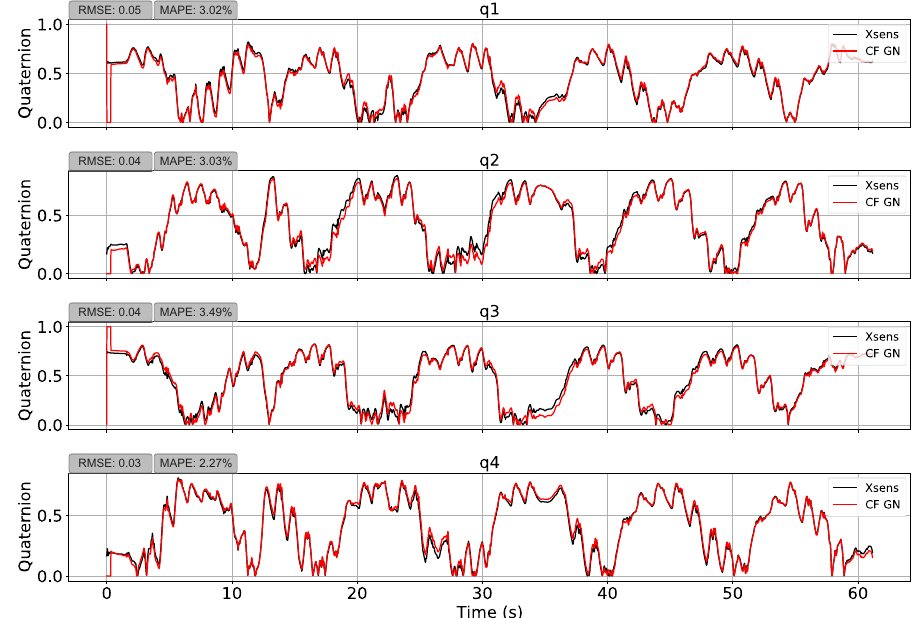
Figure 8. Orientation estimation using the Complementary Filter with Gauss–Newton. The estima- tion resulted in an average RMSE of 0.04 and an average MAPE of